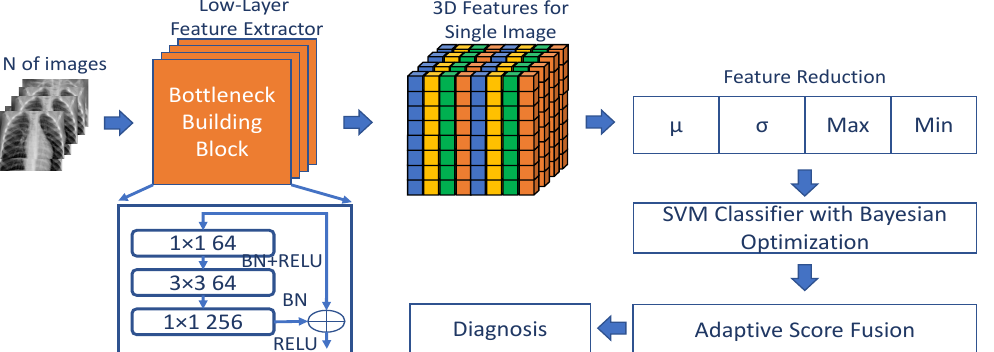
Figure 2. The proposed pneumonia diagnosis system depicting feature extraction via residual building blocks, feature reduction, SVM classifier training with Bayesian optimization, and score